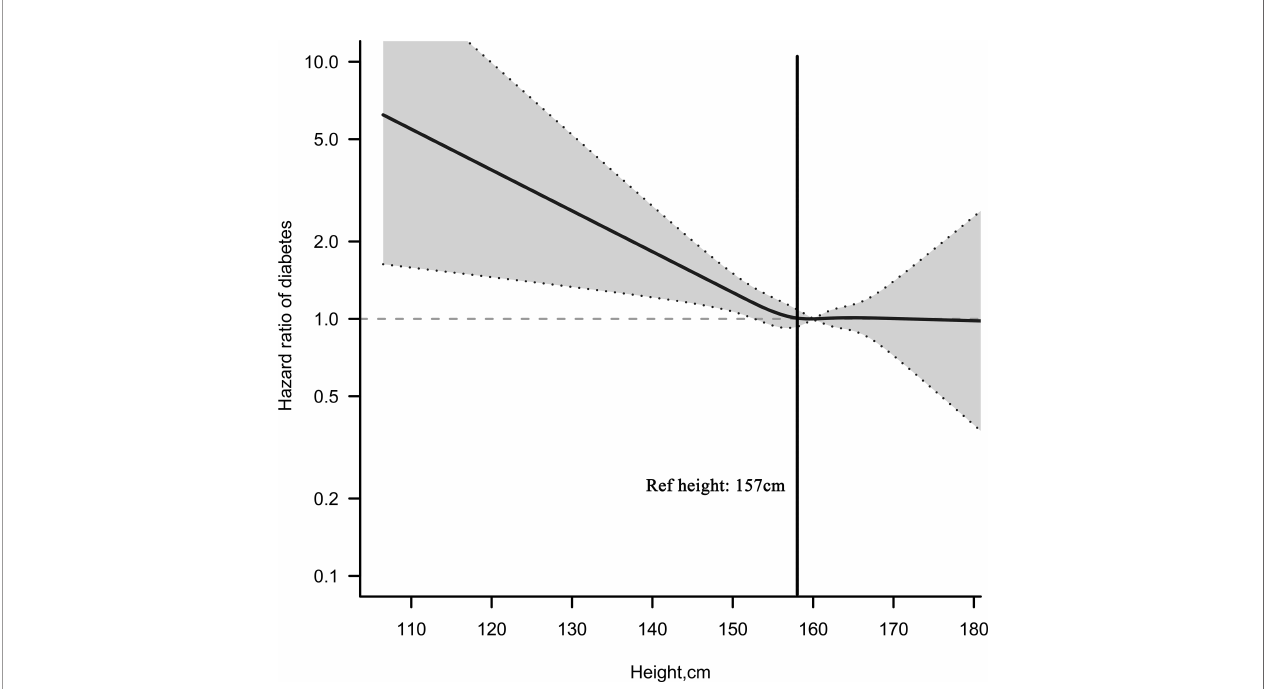
FIGURE 2 | Multivariable adjusted hazard ratios (95% con fi dence intervals) for the non-linear relationship between height and the risk of diabetes mellitus in Chinese women. Adjusted for age, BMI, FPG, family history of diabetes, SBP, DBP, smoking status, drinking status, BUN, Cr, TG, LDL-C, and HDL-C.